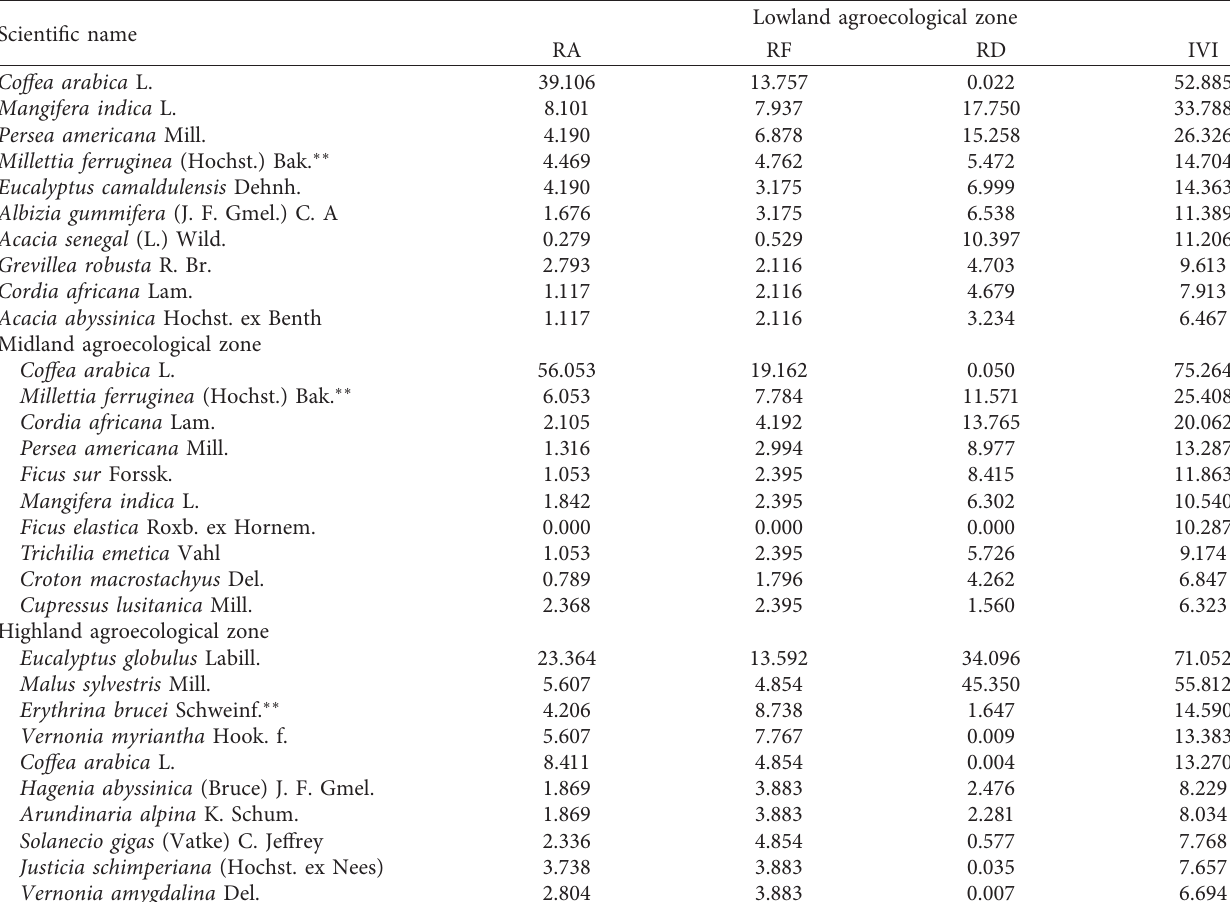
Figure 4: Local uses (a) and use category (b) of plant species recorded in the study area. Table 6: Frequency, abundance, and dominance and importance value index of major woody species in agroecological zone of the study